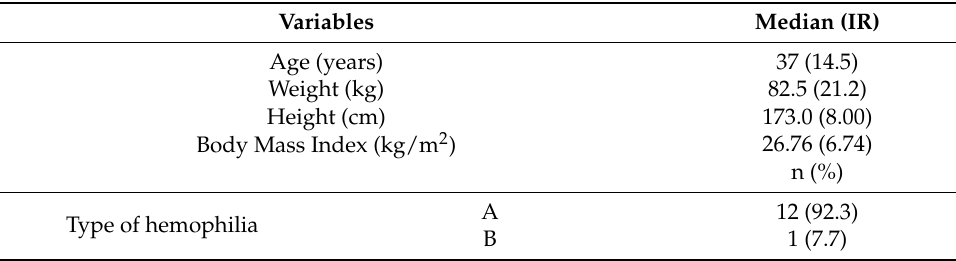
Table 1. Descriptive characteristics of patients with hemophilia at baseline.